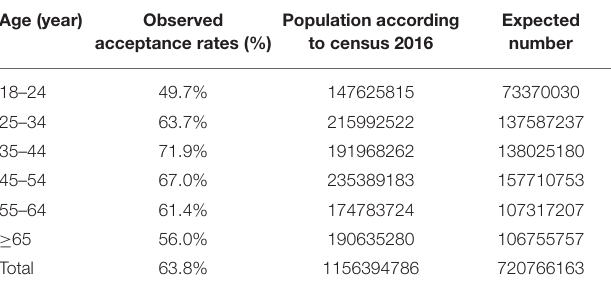
TABLE 4 | The process of calculating age-standardized vaccination rate. Age (year) Observed Population according acceptance rates (%) to census